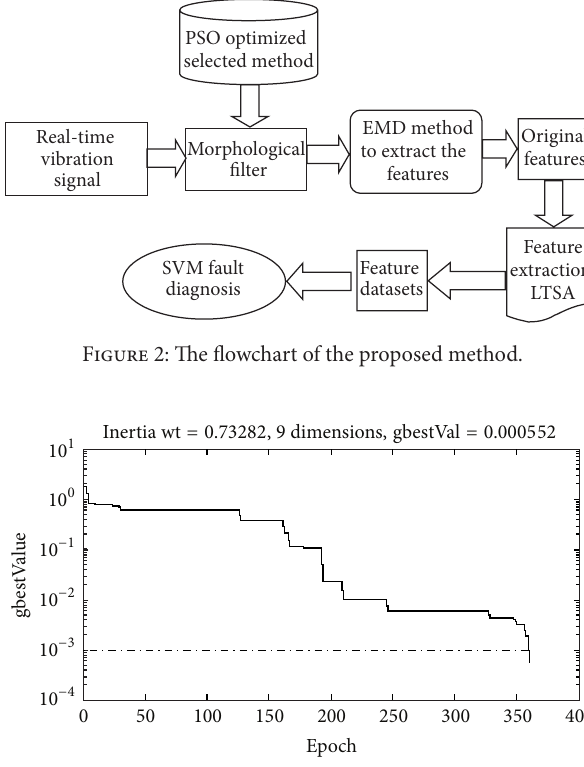
Figure 3: The curve of the PSO optimization